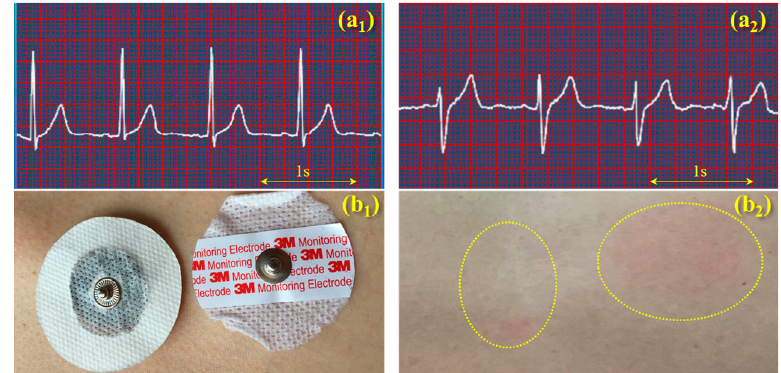
Figure 8. Comparison of the self-developed gel electrode and commercial 3M electrode in the performance of ECG acquisition and wearing comfort; ( a 1 ) ECG signal obtained from the self-developed gel electrode and ( a 2 ) the ECG signal from the 3M electrode, the scale bar means 1 s across four units for recording the heart rate; ( b 1 ) two electrodes attached on a human skin at the same time, and ( b 2 ) the skin reaction after six hours of wearing for the self-developed hydrogel (left) and the commercial hydrogel (right).